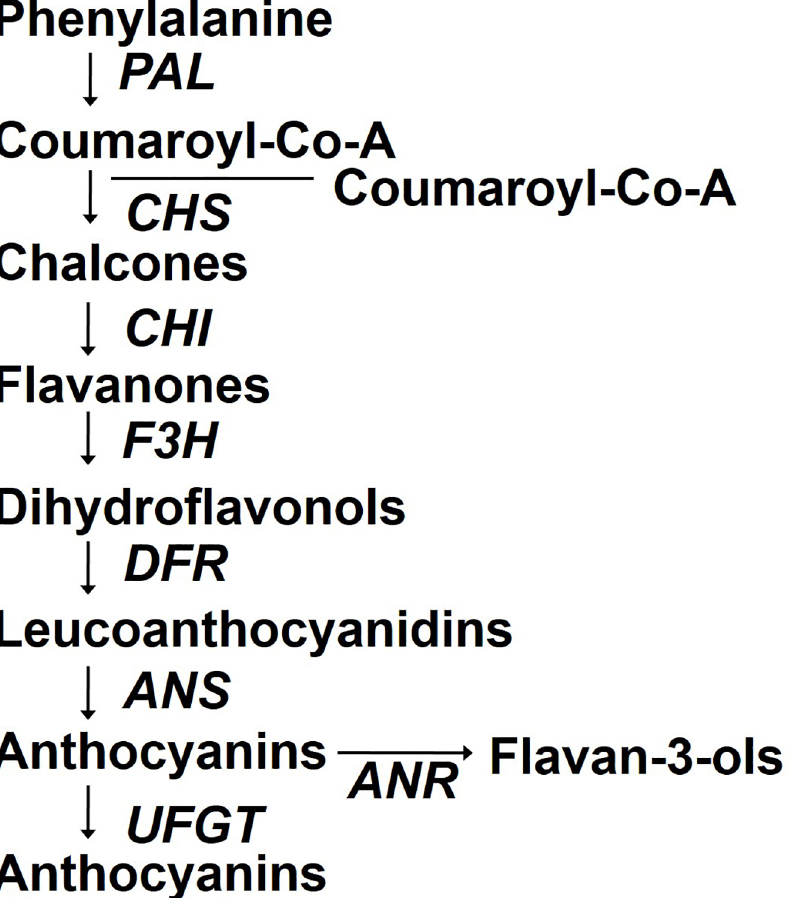
Fig 1. Diagram of the flavonoid pathway. The enzymes for each step are italicized,with the following enzymes requiredfor anthocyanin biosynthesis:chalconesynthase ( CHS ), chalconeisomerase( CHI ), flavanone-3-hydroxylase ( F3H ), dihydroflavonol-4-reductase ( DFR ), anthocyanidin synthase ( ANS ), anthocyanidin reductase( ANR ) and UDP-glucose: flavonoid-3-O-glycosyltranferase( UFGT